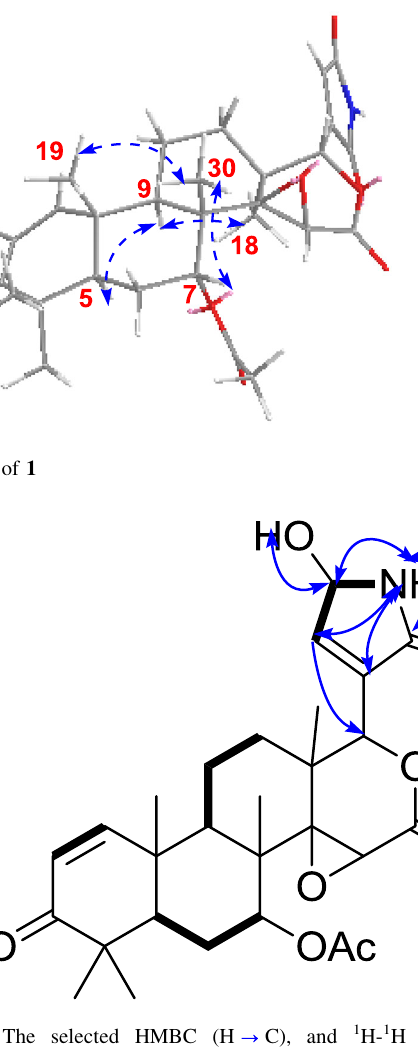
Fig. 4 The selected HMBC (H C), and 1 H- 1 H COSY ( ) correlations of compound 3